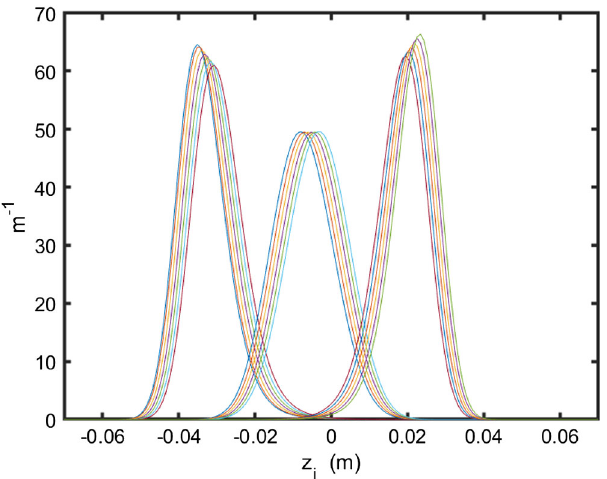
(red).FIG. 23. HHC þ MC, single gap, I